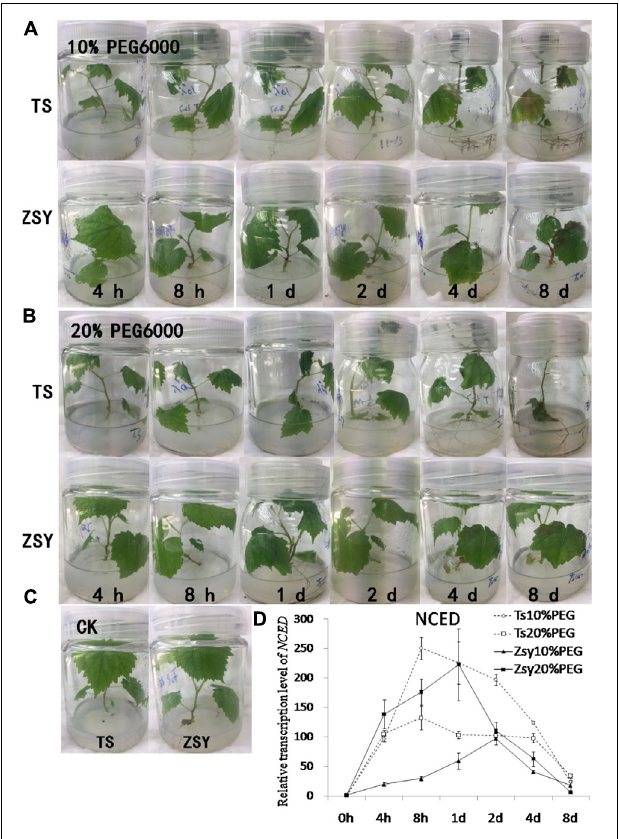
FIGURE 1 | Phenotypes of ‘Thompson seedless’ (TS) and ‘Zuoshan-1’ (ZSY) plants under different stress conditions in vitro . The osmotic stress